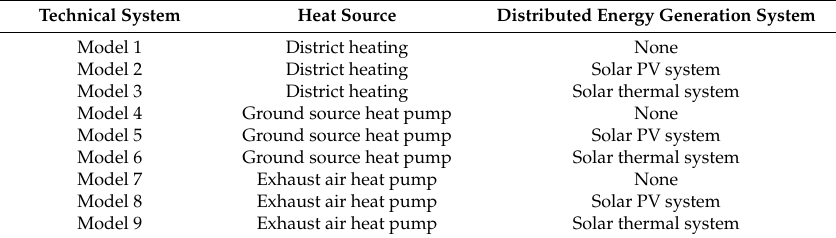
Table 1. Main heat source and DEG system in the different simulation models.